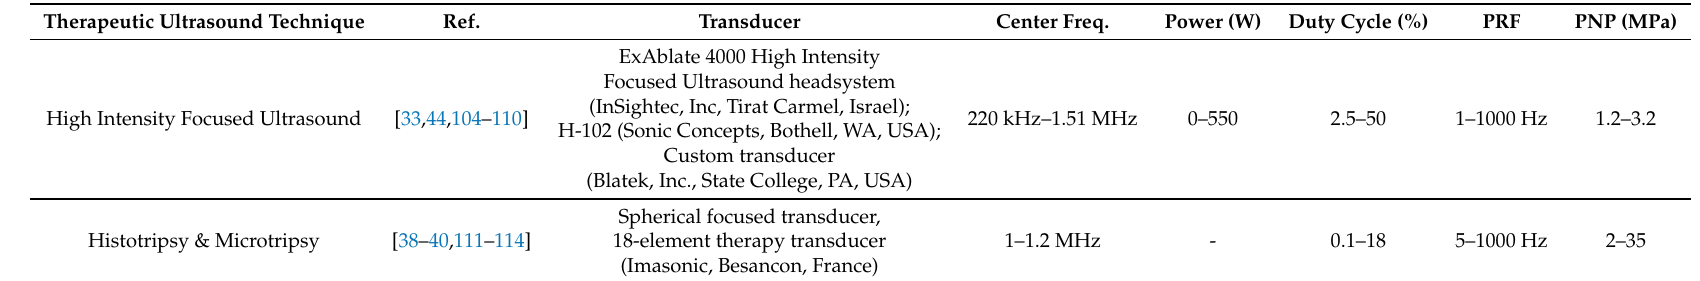
Table 2. Ultrasound Parameters for Therapeutic